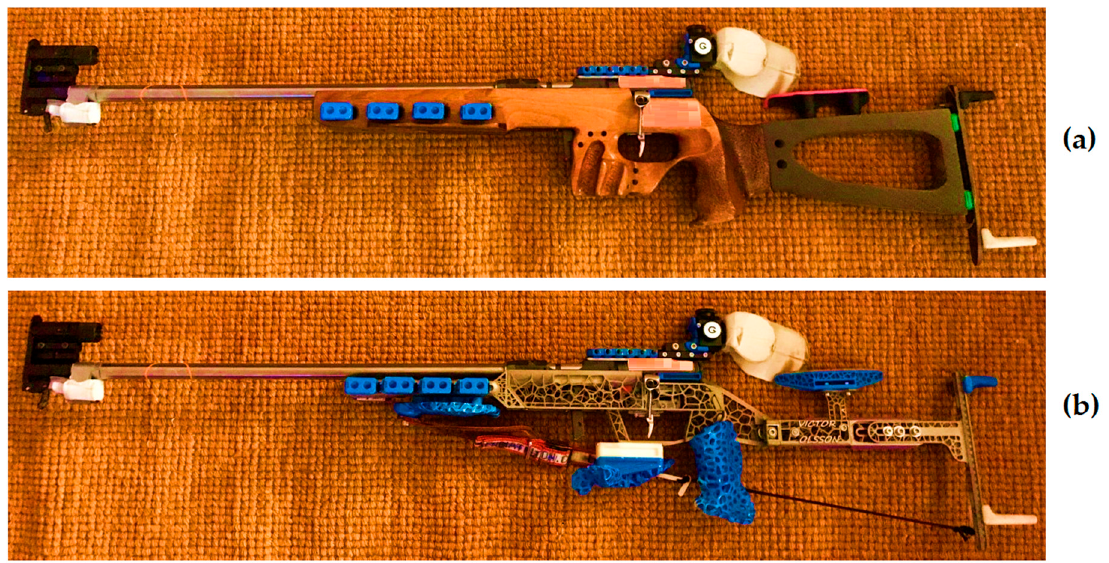
Figure 1. ( a ) Original ANSCHÜTZ 1827 F biathlon rifle with individualized, mainly wooden stock and ( b ) its modification with additively manufactured stock and PA 2200polymer elements (in blue